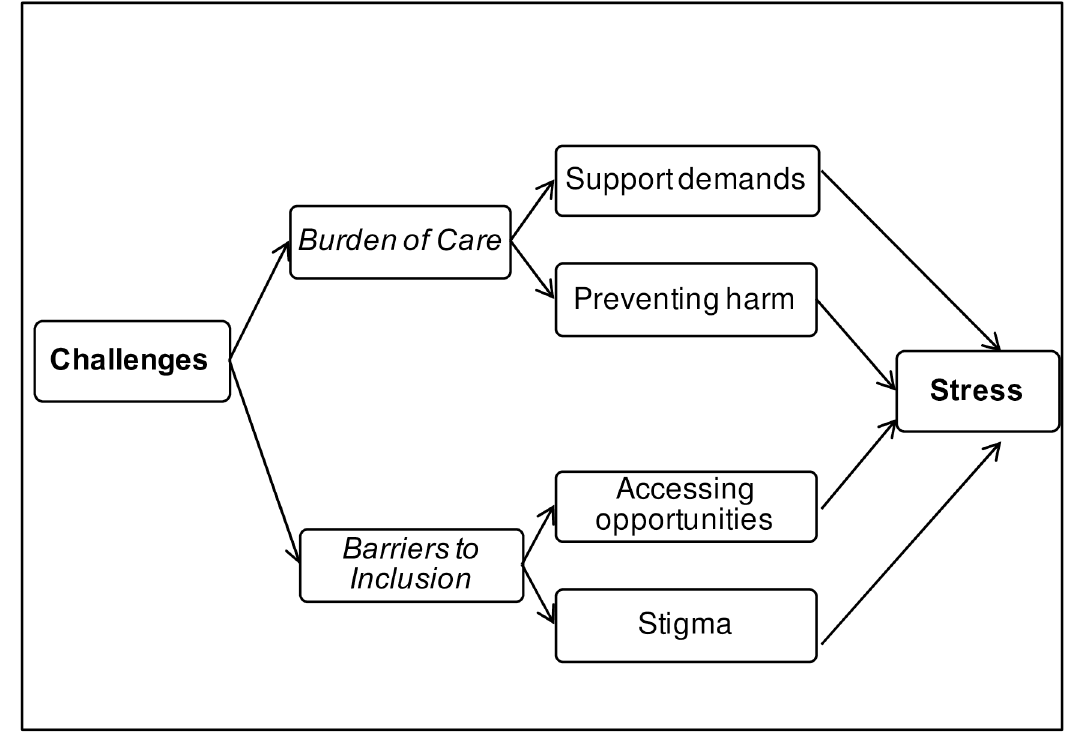
Fig 2. Thematic map summarising the perceived challenges associated with